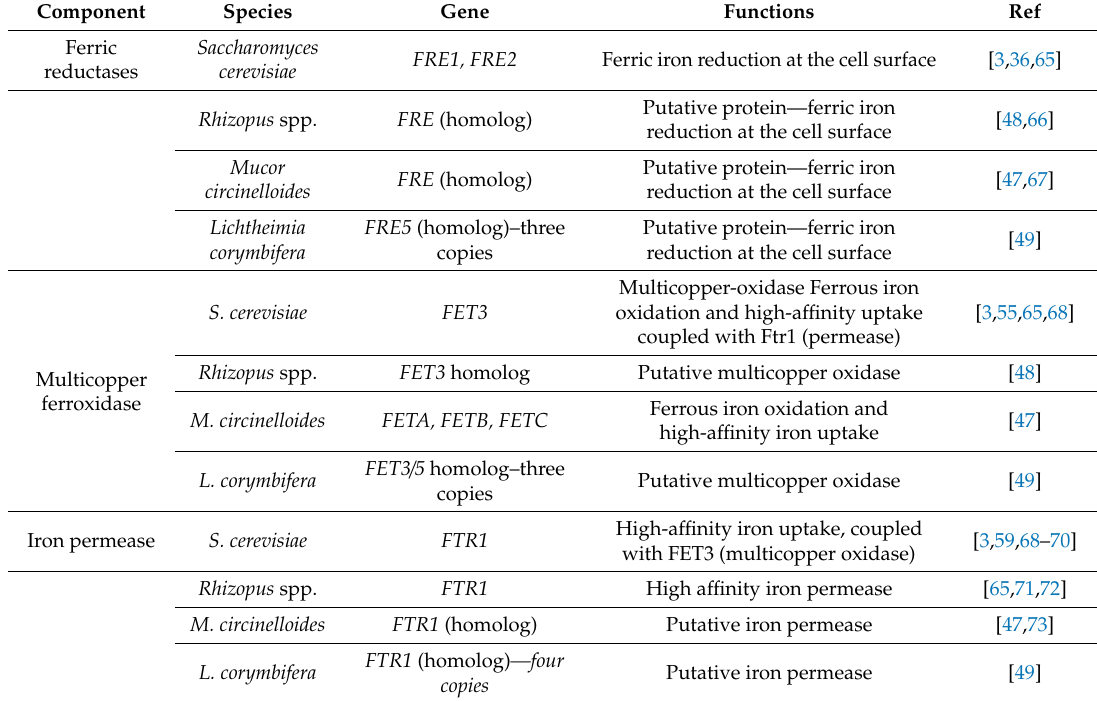
Table 1. Reductive iron acquisition system in Saccharomyces cerevisiae and pathogenic Mucoralean species. Component Species Gene